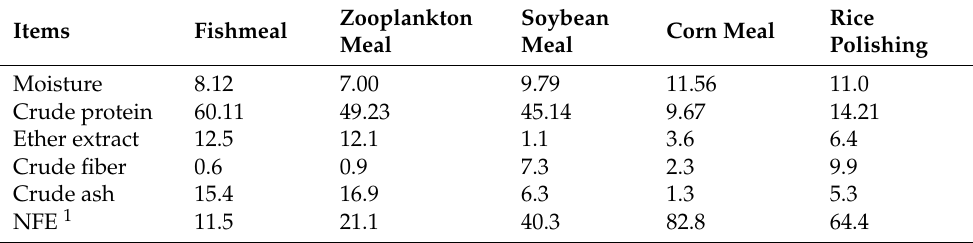
Table 1. Approximate composition of the ingredients used in the experimental diet (dry matter, %). Items Fishmeal